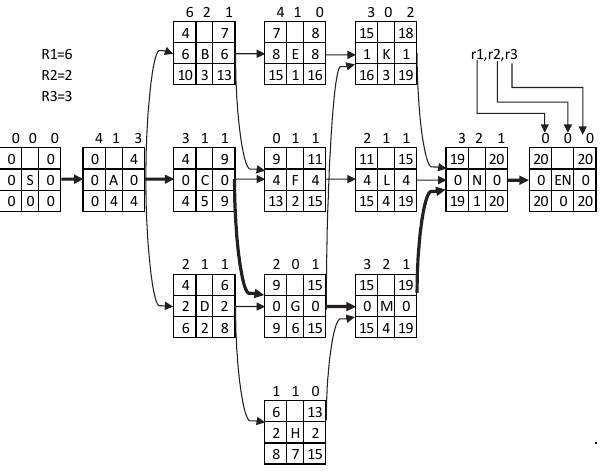
Fig. 13. Project network for the illustrative